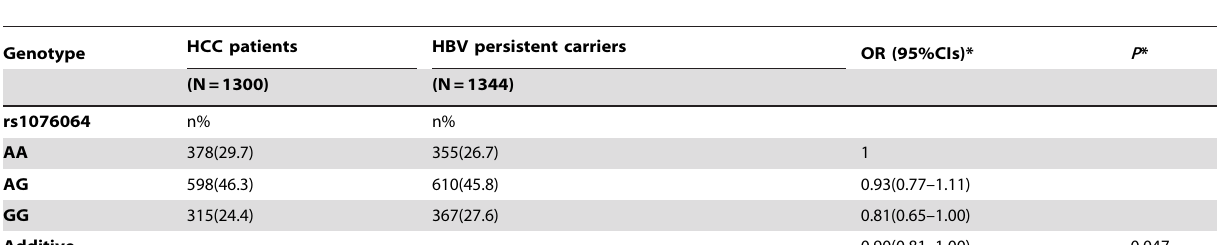
Table 1. Genotype frequencies of rs1076064 and HBV persistent infection and HCC susceptibility.